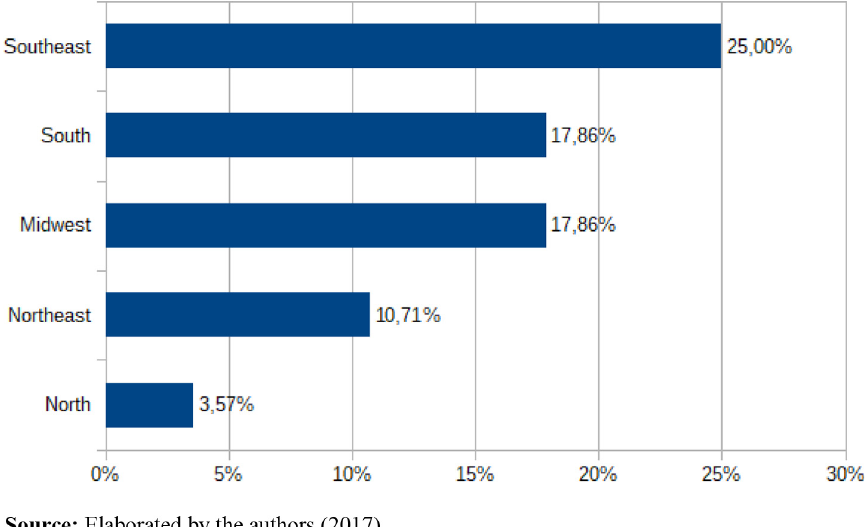
Figure 4. Location of the innovation experiments